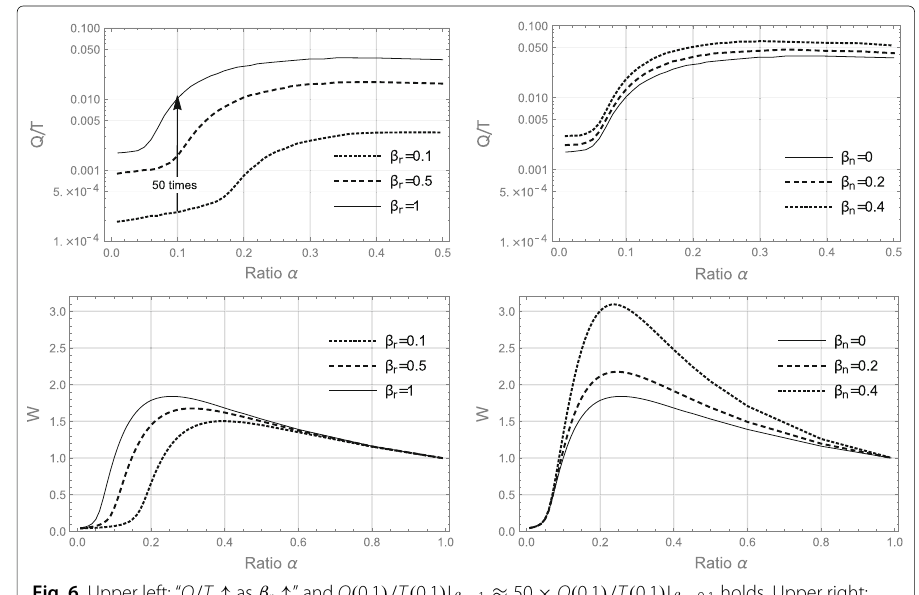
≈ 50 × Q ( 0.1 )/ T ( 0.1 ) | β holds. Upper right: r = 1 r = 0.1